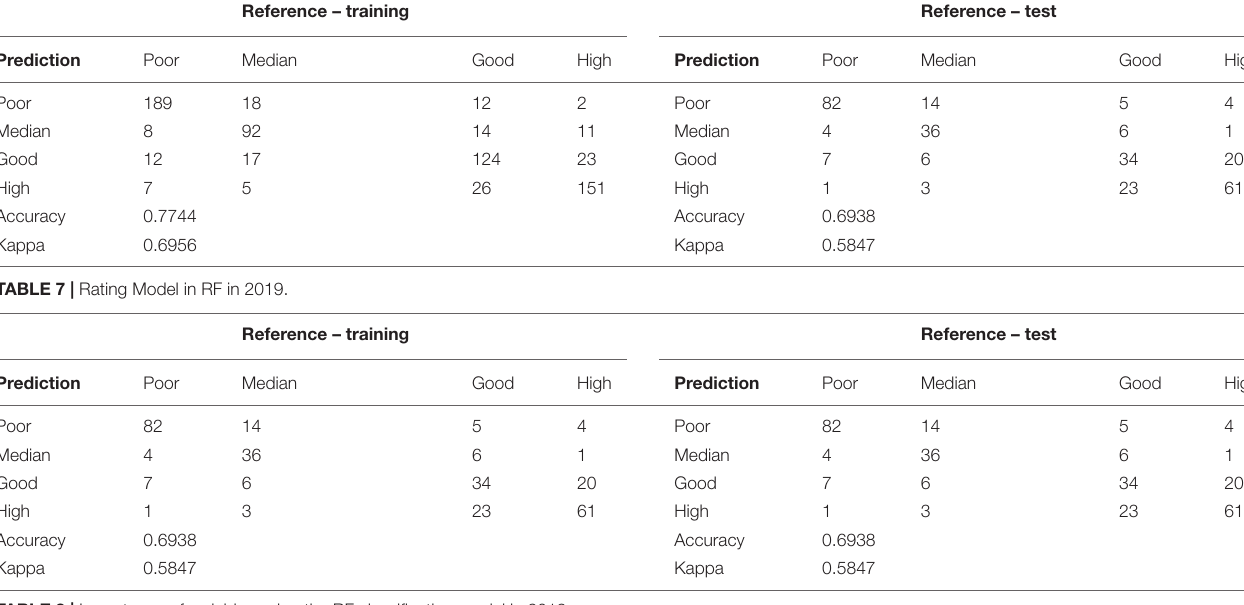
TABLE 8 | Importance of variables using the RF classification model in